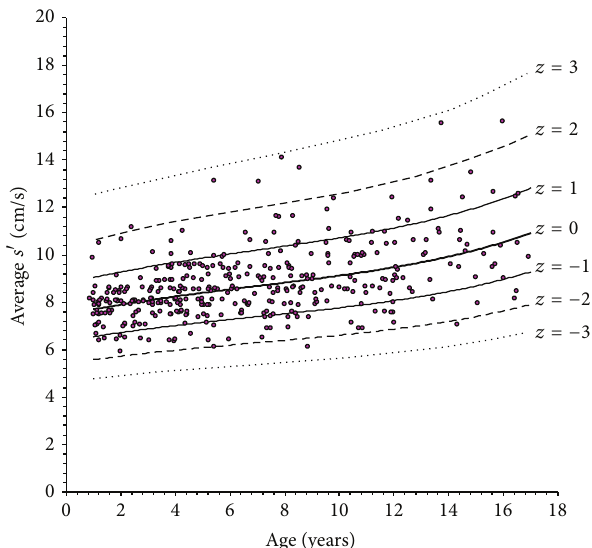
Figure 4: Scatterplot of peak late diastolic left ventricular longitu- dinal velocity ( 𝑎 󸀠 ) versus